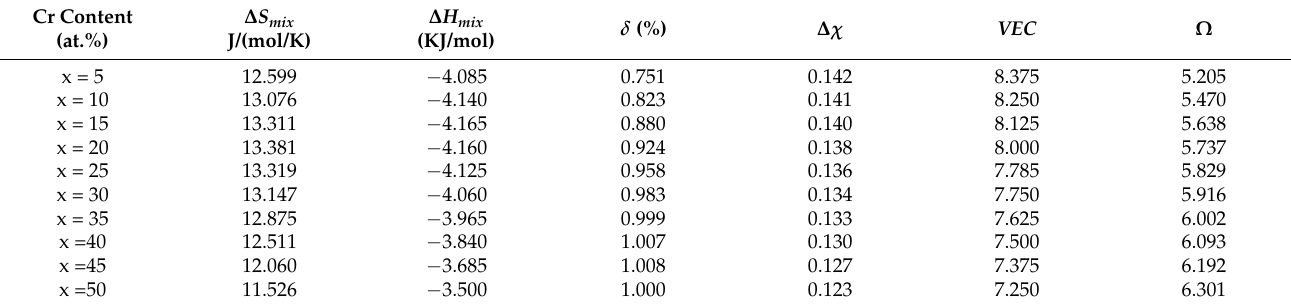
Table 1. Solid solution formation parameters of Cr x HEA